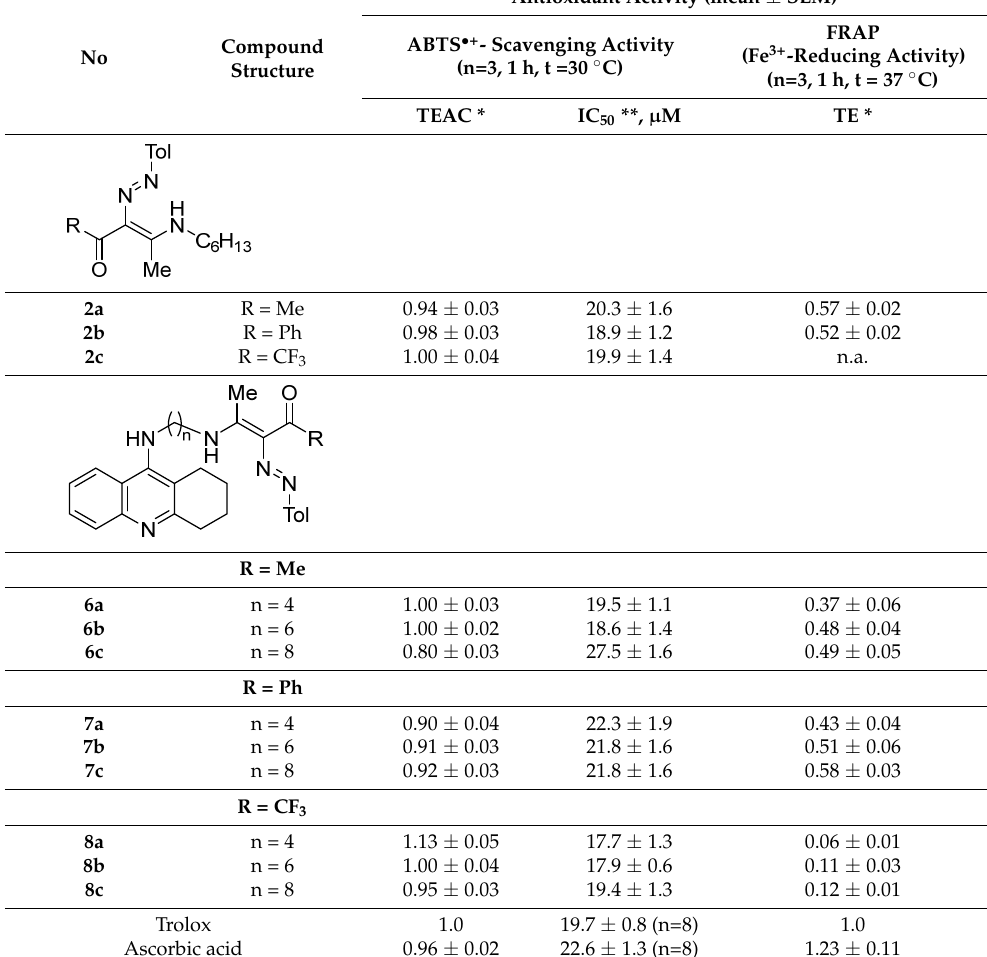
Table 2. Antioxidant activity of compounds 2a–c, 6a–c, 7a–c, 8a–c .